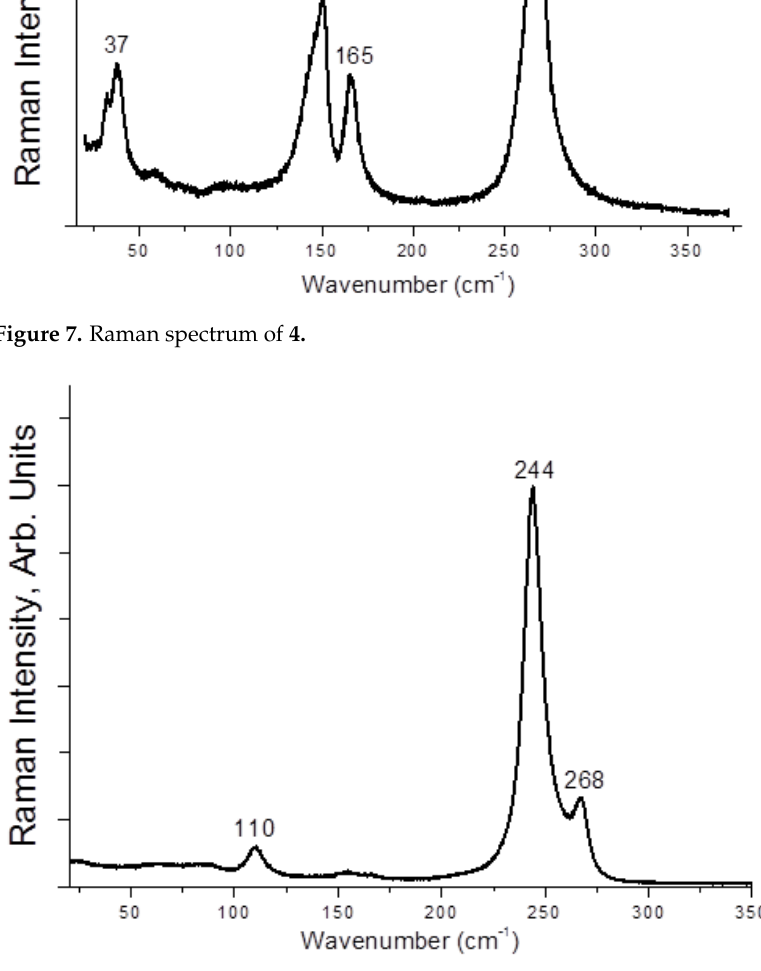
Figure 8. Raman spectrum of 3.